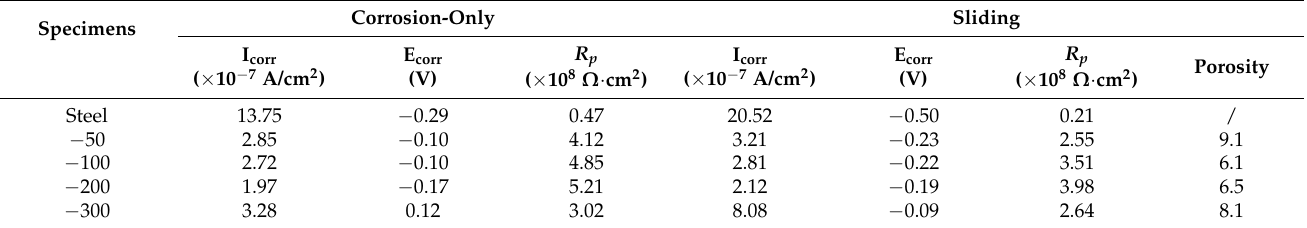
Figure 8. Potentiodynamic polarization curves of Ti-DLC coatings under: ( a ) corrosion-only ( b ) sliding in 3.5 wt% NaCl aqueous solution. Table 2. The fitting results of the polarization curves in the corrosion state and sliding